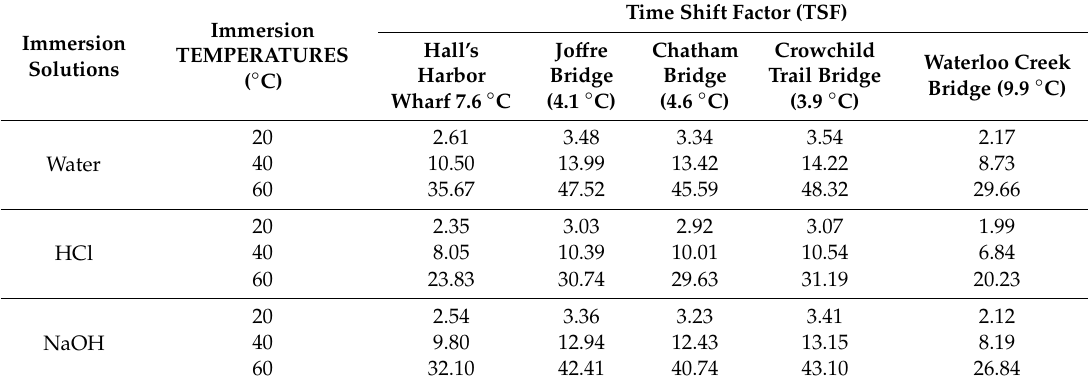
Table 7. Time-shift factor of CFRP composites at different annual temperature